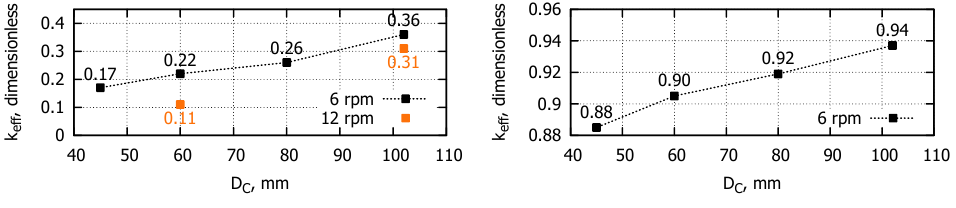
Figure 16. The effective segregation coefficient k eff of carbon ( left ) and boron ( right ) obtained for different crystal diameters D C and crystal rotation rates of 6 rpm (black) and 12 rpm (orange).